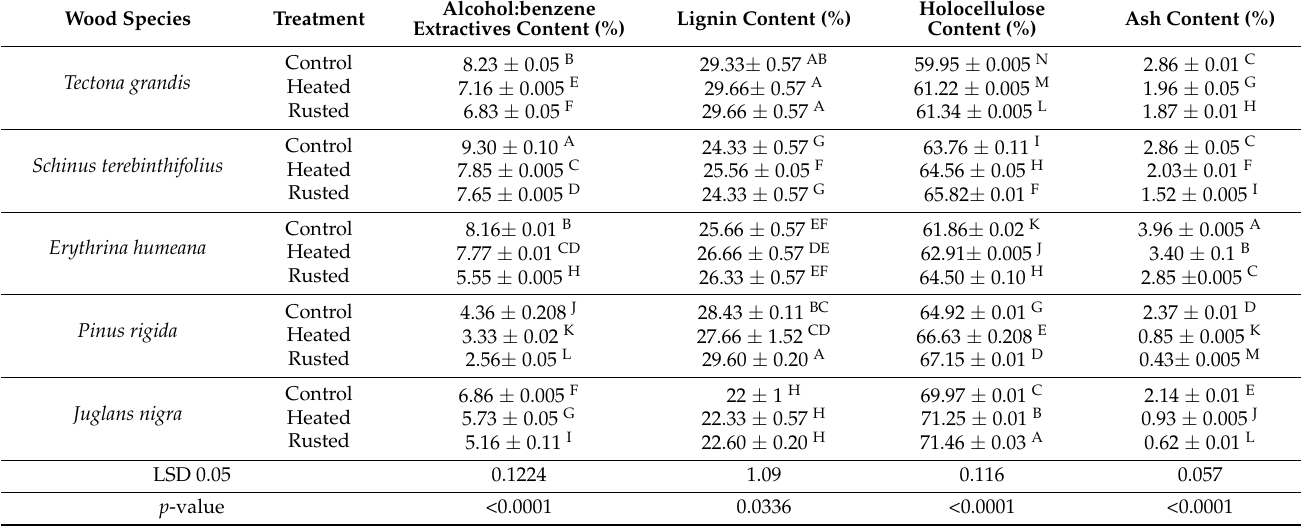
Figure 3. Wood samples with different treatments (heated and rusted woods) compared to control treatment (untreated wood) prepared for the testing of their mechanical properties. (1) Schinus terebinthifolius , (2) Pinus rigida , (3) Tectona grandis , (4) Erythrina humeana and (5) Juglans nigra . Table 3. Chemical composition of the wood